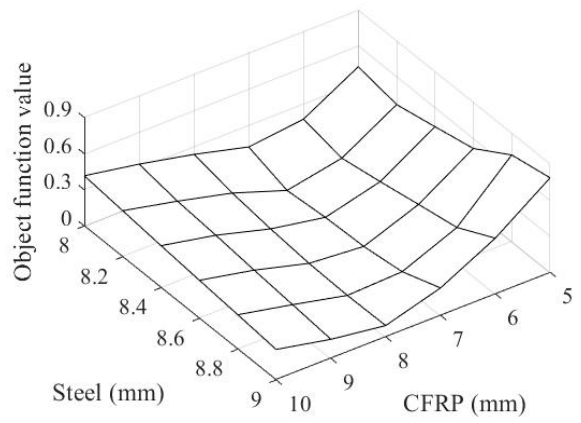
Figure 12. Objective function surface.